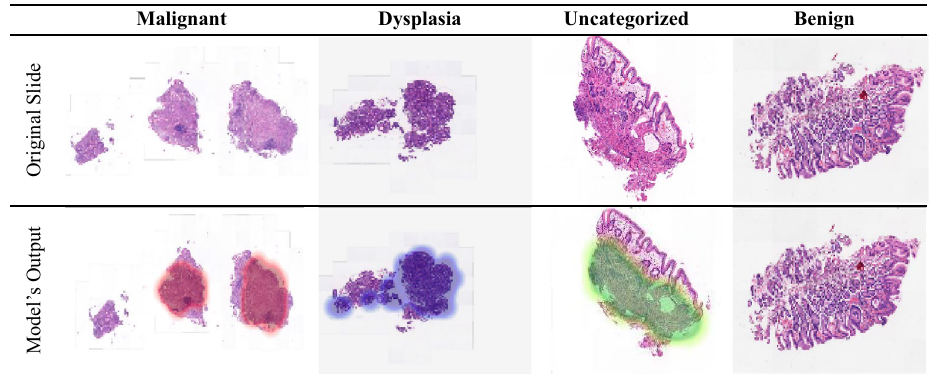
Figure 13. The final output of the CNN trained based on the cleaned malignant, dysplasia, uncategorized, and benign data and the corresponding heatmaps of abnormal regions.